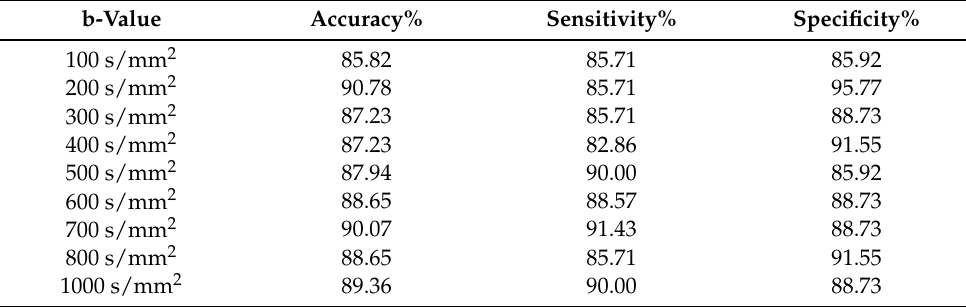
Table 10. The performance results of GoogLeNet are close to the results of both AlexNet and VGGNet. These results boosts the feasibility of the transfer learning in diagnosing prostate cancer. Table 10. Performance of GoogLeNet at 9 b-values using 141 ADC